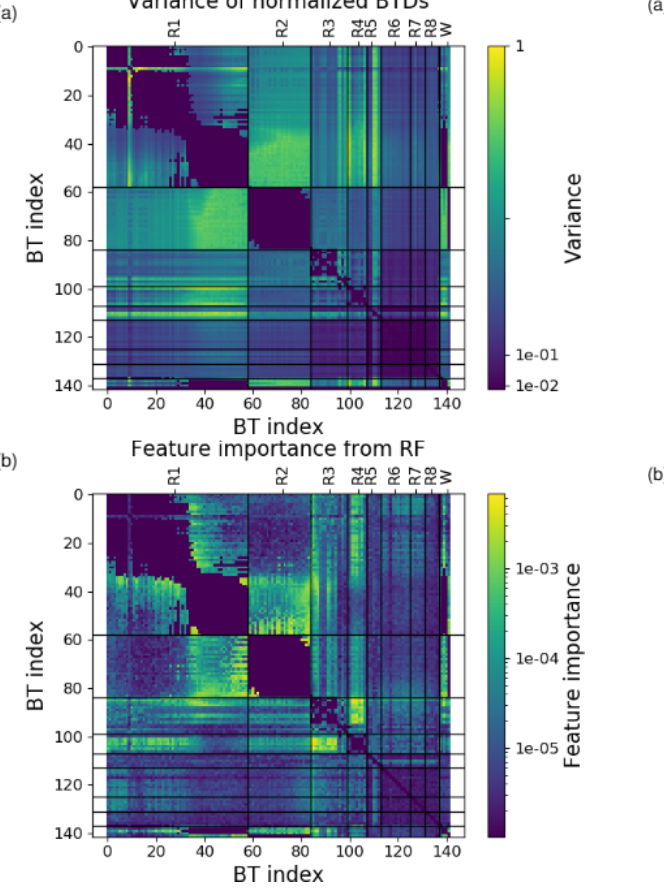
Figure 4. Variance of normalized BTDs (a) and feature importance as estimated by the RF classifier (b) . The BT index numbers on the x and y axis correspond to the spectral regions as listed in Table 1.